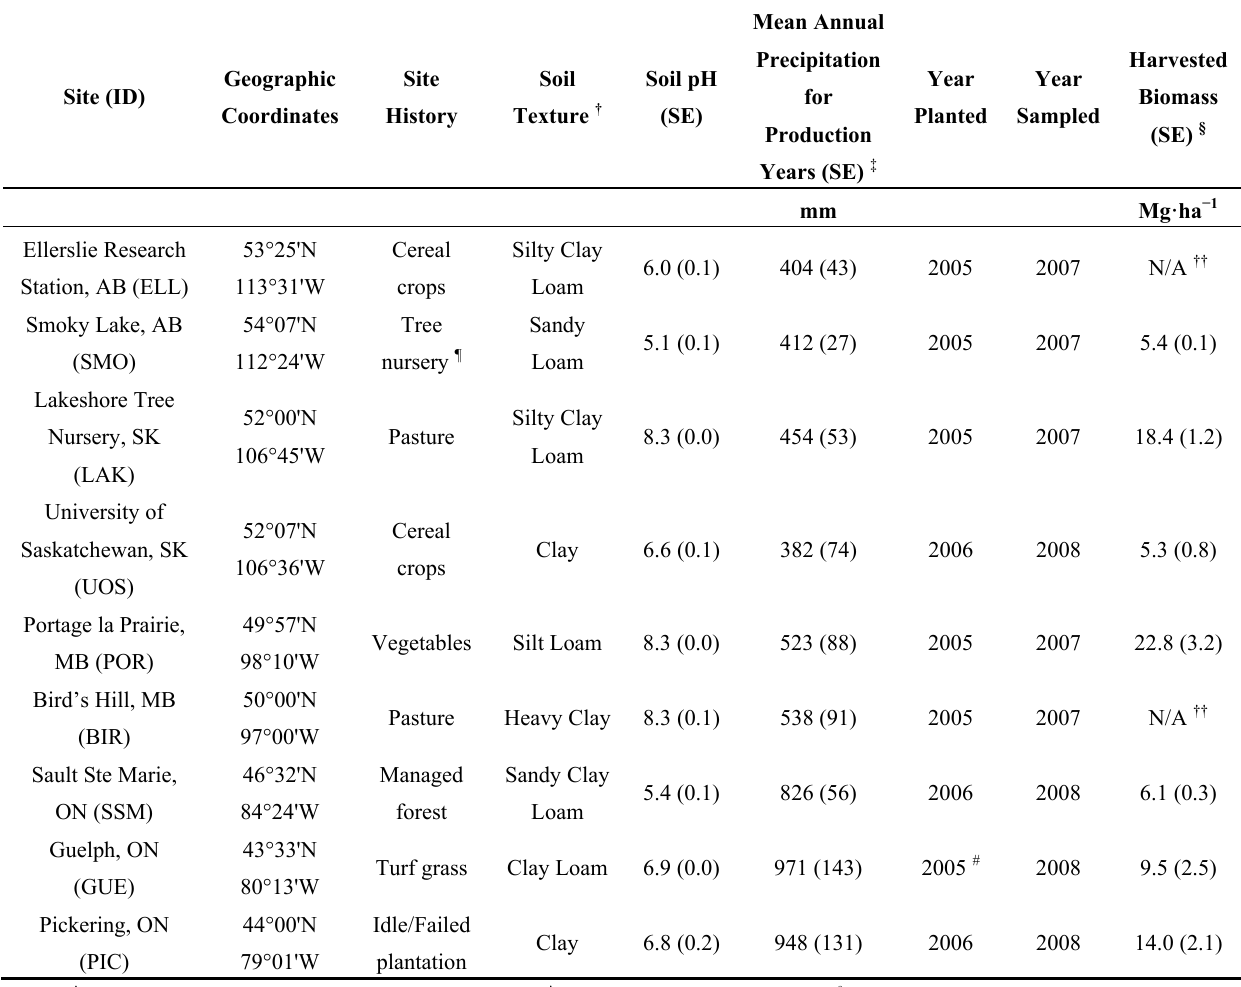
Table 1. Site names, locations, history, soil texture, soil pH, precipitation and harvested biomass summary data for nine S. purpurea “Hotel” plantations included in this